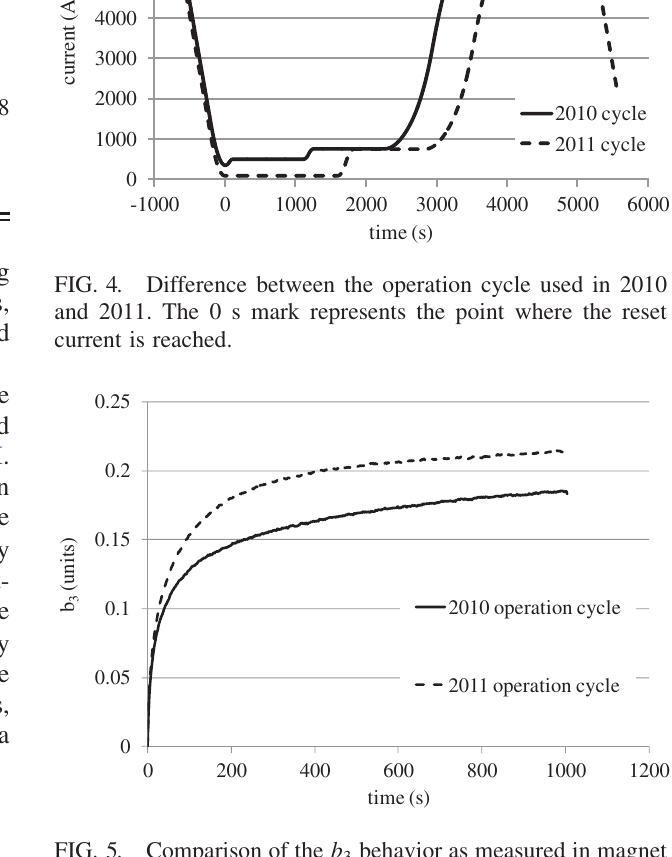
FIG. 5. Comparison of the b 3 behavior as measured in magnet MB1132. The values were shifted down along the y axis to cancel the initial